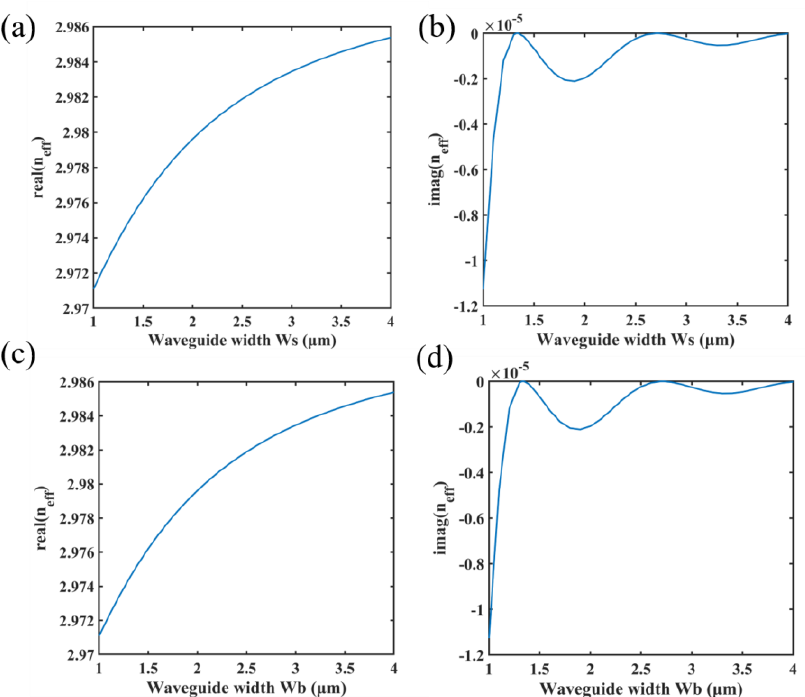
Figure 10. Dispersion effects at a single wavelength: variation of the real ( a ) and imaginary parts ( b ) of the effective refractive index with the width of the waveguide of a straight waveguide at a wavelength of 1.55um, the real ( c ) and imaginary parts ( d ) of the effective refractive index curve of the bent waveguide at 1.55 μm wavelength as a function of waveguide width Wb when the bending radius Rb is 500 μm.